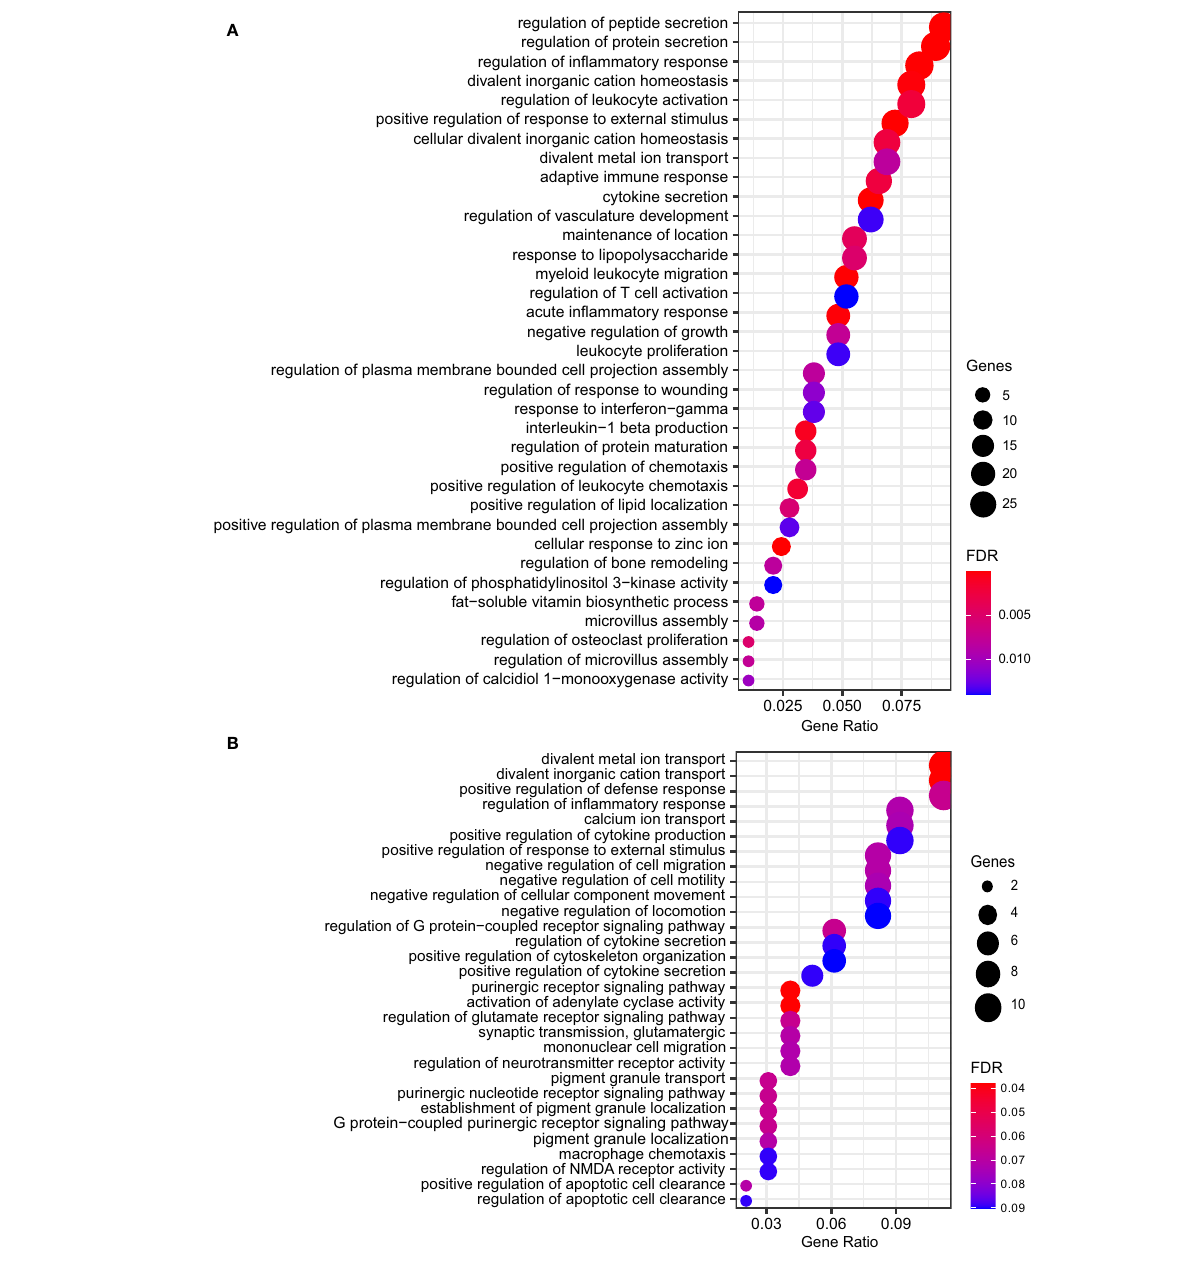
FIGURE 2 | Dot plot showing the top signi fi cant GO biological processes enriched from ORA of genes (A) upregulated (n = 35) or (B) repressed (n = 30) by M. leprae infection. Gene ratio is the fraction of genes belonging to an ontology over the total number of modulated genes. Circle size shows the number of modulated genes per biological process. FDR, false discovery